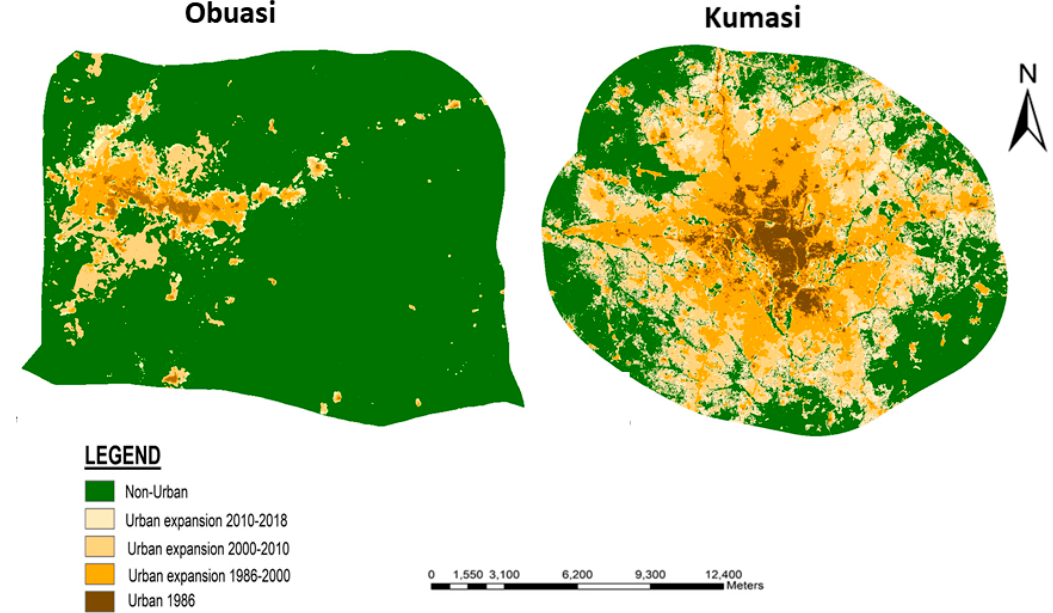
Figure 5. Urban expansion in Obuasi and Kumasi.